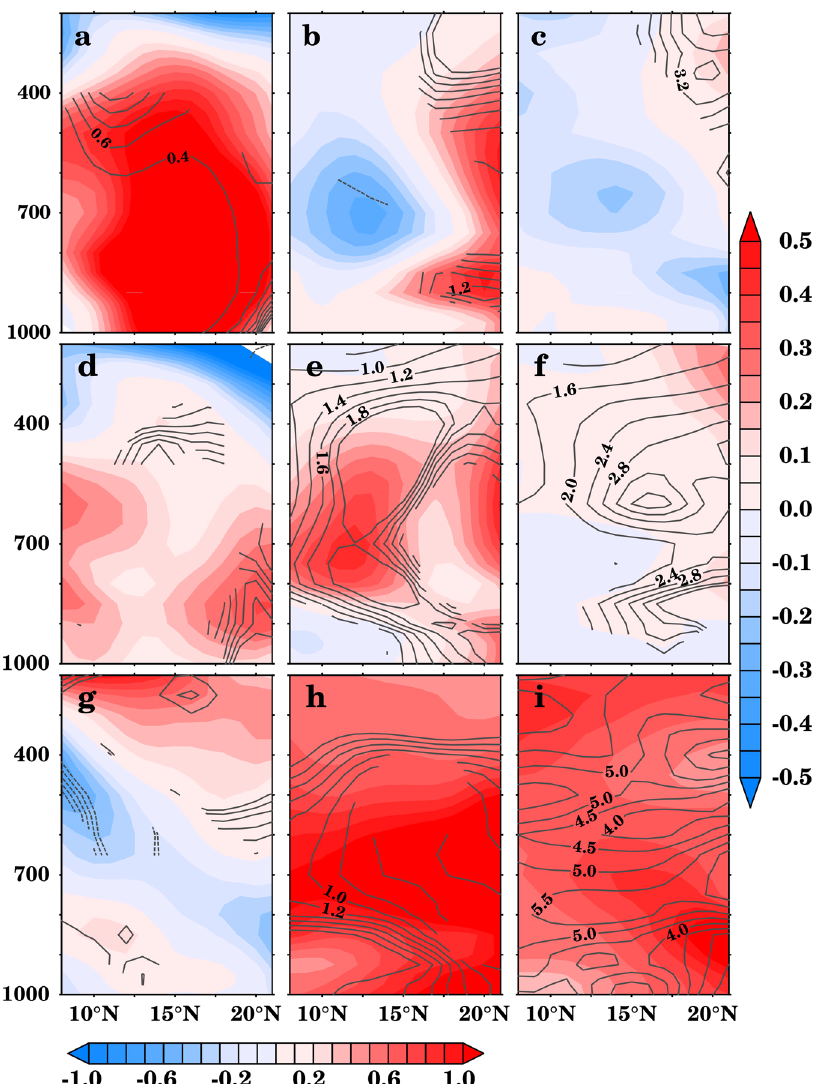
Fig. 6 Concurrent evolution of circulation and moist processes to WG rainfall variability in latitude-height section. Latitude-height section (averaged over 70°E – 73°E) of a zonal wind (m/s), b MSE (kJ/kg), and c virtual temperature (°C) composite anomaly difference for excess to de fi cit years (shaded) and their regression with the WGI (contour, statistically signifcane at 90% con fi dence level) for period 1 and d – f and g – i are same but for period 2 and period 3,